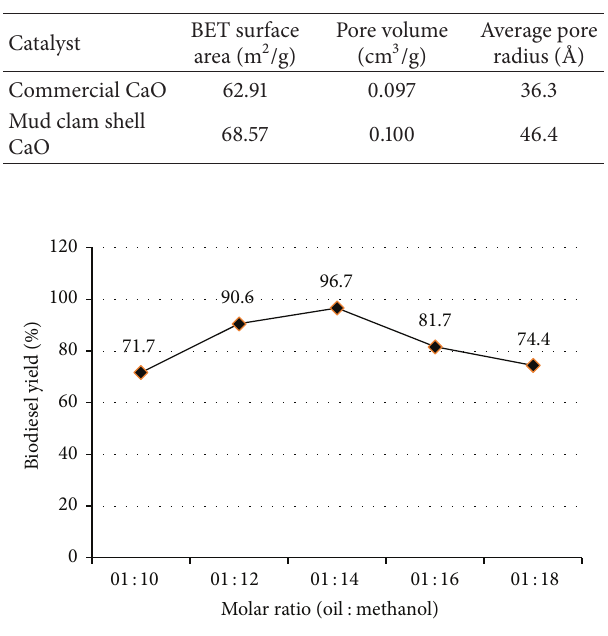
Figure 5: Molar ratio of oil to methanol versus biodiesel yield (%).